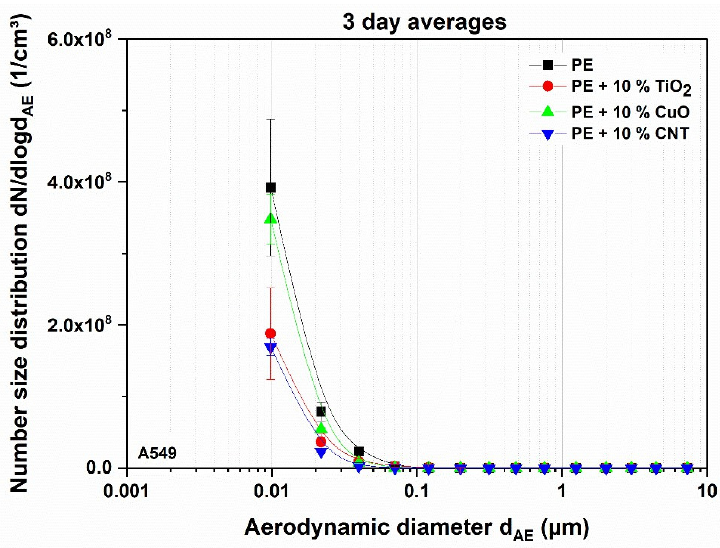
Figure 3. Average number size distribution of nanocomposite materials downstream of the thermal treatment, as determined via ELPI, subsequently applied to A549 cells. Error bars indicate standard deviation derived from three independently performed experiments.